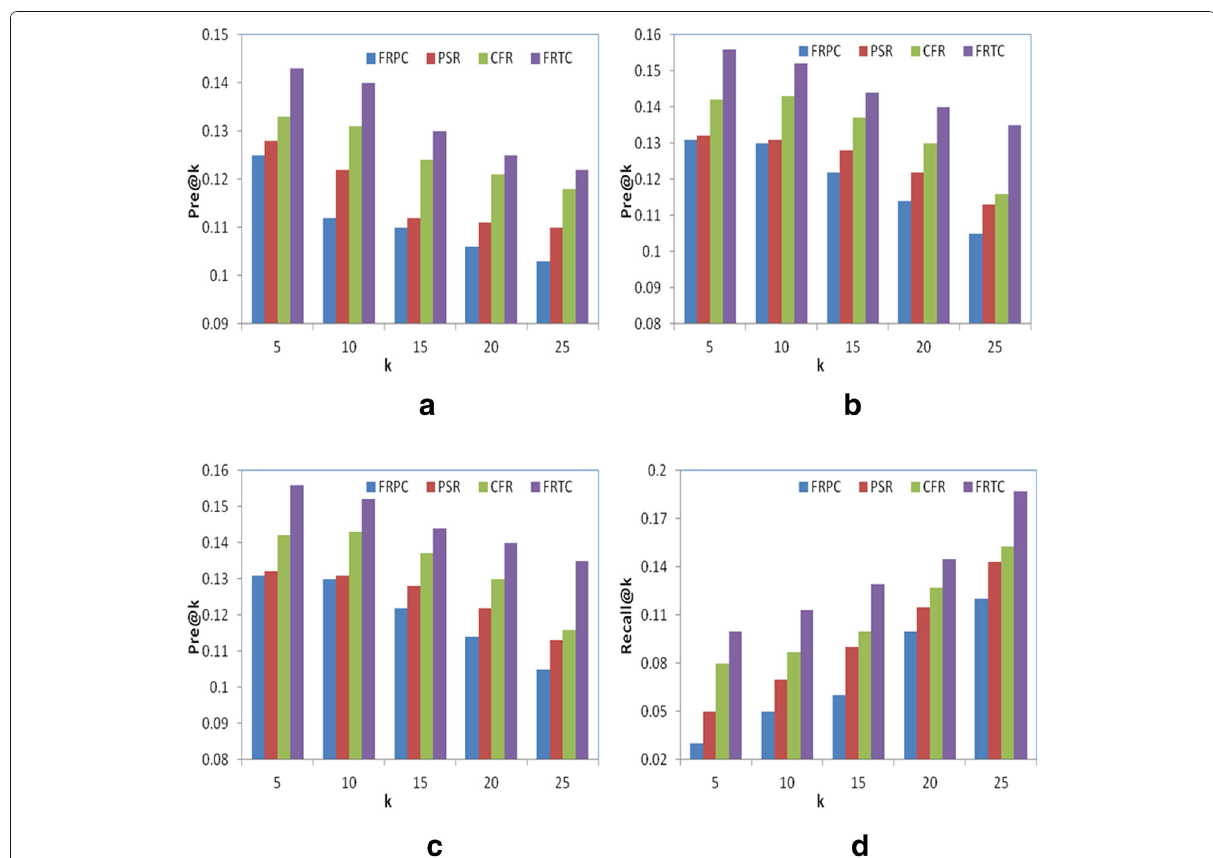
Fig. 5 Friend Recommendation Performance comparison. a Pre@k-Foursquare. b Recall@k-Foursquare. c Pre@k-Gowalla. d Recall@k-Gowalla